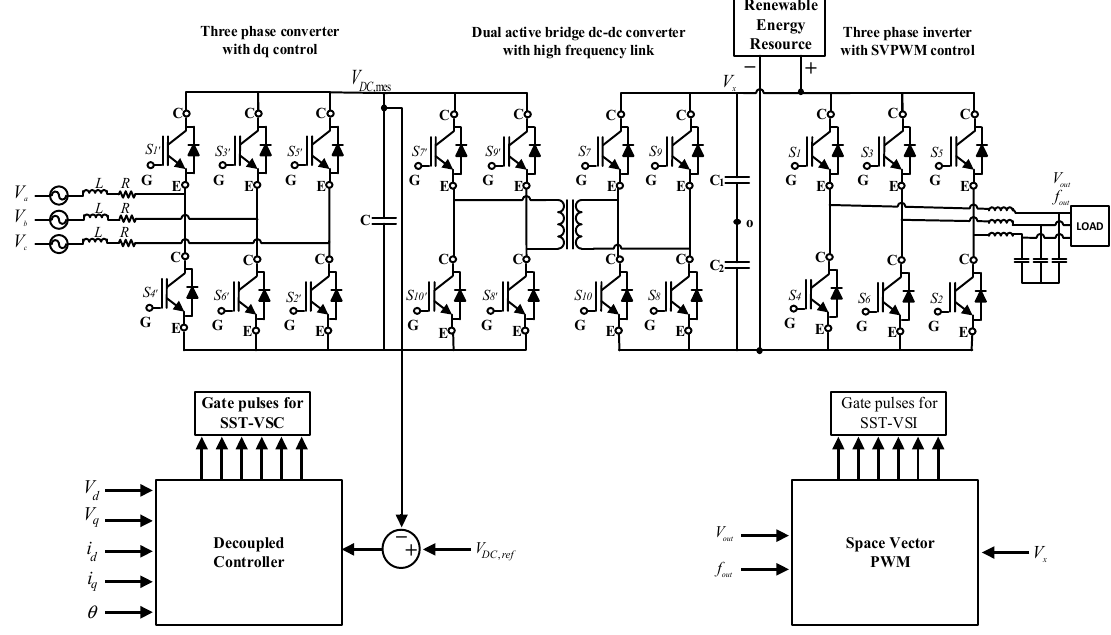
Figure 1. Proposed circuit diagram of the solid-state transformer.